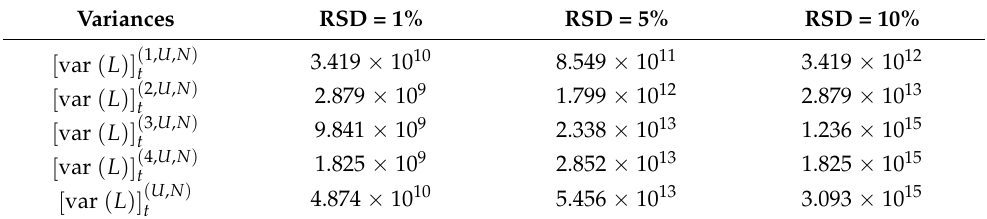
Table 4. Comparison of variances for various relative standard deviations (RSD) of the normally distributed and uncorrelated microscopic total cross sections.